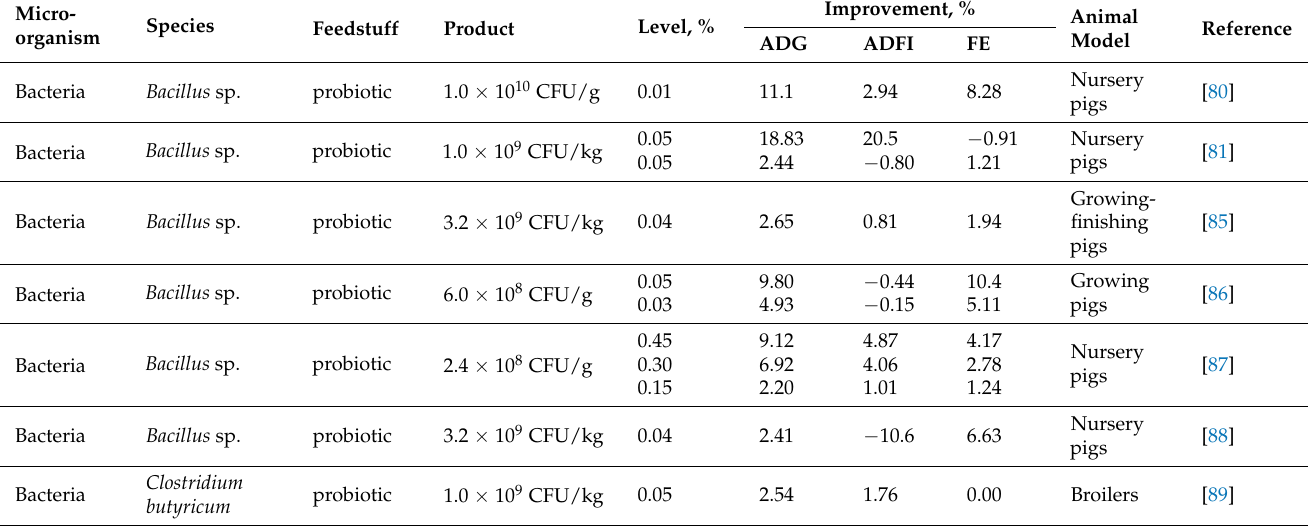
Table 2. Examples of bacteria as functional feed